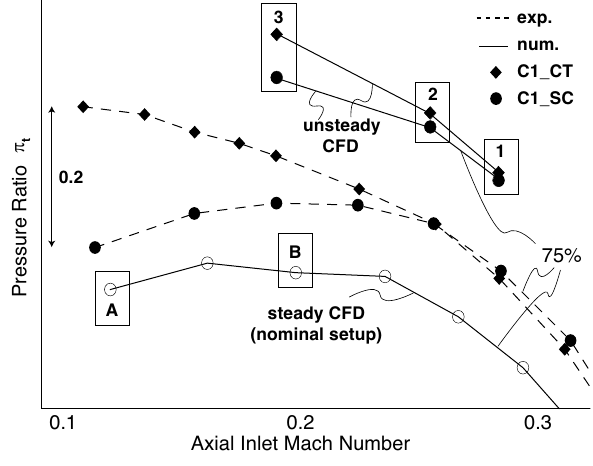
Figure 6. Unsteady and steady RANS results for CT and smooth casing (SC) in comparison to experimental data C1